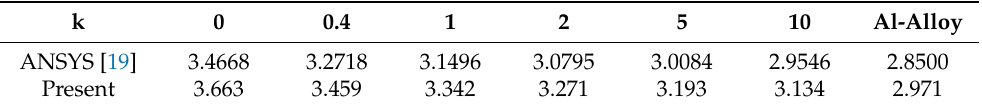
Table 2. Comparison of non-dimensional fundamental frequencies of simply supported functionally graded CNT/Al-alloy composite beams with ANSYS results.